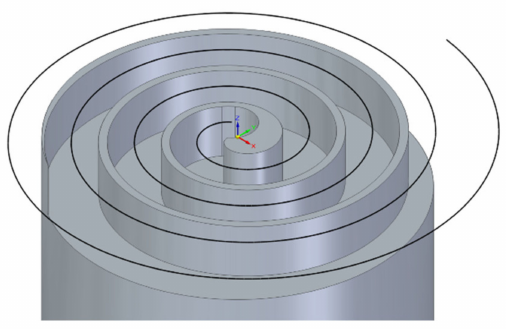
Figure 14. Spiral